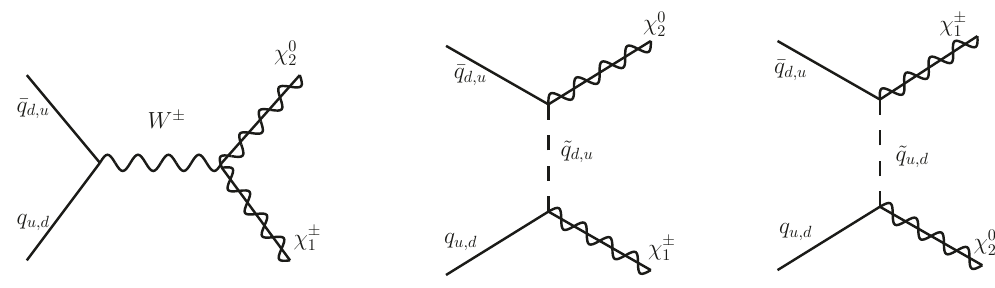
Figure 1 . Leading order diagrams contributing to the direct production of electroweakinos at the LHC in the case that the spectrum is